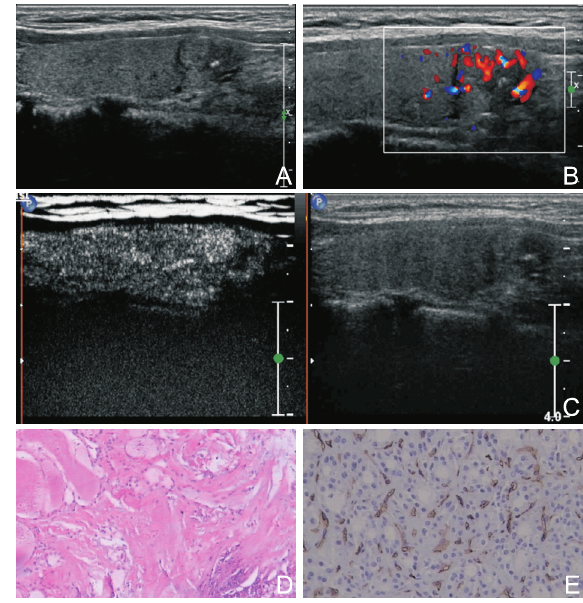
Figure 2 A 42-year-old female with a 1.03*0.91 cm nodule in the right thyroid lobe. (A) Gray-scale US showed a mixed echoic nodule with calcification in the right lobe of the thyroid gland. (B) CDFI: There were blood flow signals in the nodule. (C) The iso-echoic area of the nodule showed hyper-enhancement. (D) Surgical pathology showed a nodular goiter, part of follicular epithelial hyperplasia, interstitial fibrous tissue hyperplasia, hyaline change and calcification (HE, ×100). (E) Immunohistochemical staining of the thyroid nodule showed a higher microvessel density (CD34,